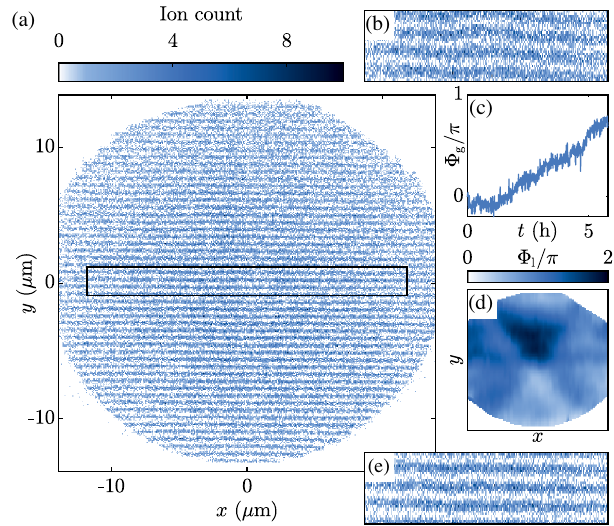
FIG. 4. Field of view. The FOV was investigated for the voltage configuration corresponding to the largest magnification shown in Fig. 3(b) ( M ¼ 1441 ). (a) Measured data (sum over 1200 experimental cycles, object coordinates), corrected for a global phase Φ (drift of the lattice) and a local phase Φ (distortion). g l The marked region is enlarged in panels (b) (raw data) and (e) (phase-corrected data). Panel (c) shows Φ over time, and g panel (d) shows Φ as a function of the spatial coordinates. The l local phase Φ is extracted from the local deviation of the l experimental data from the expected regular lattice structure.